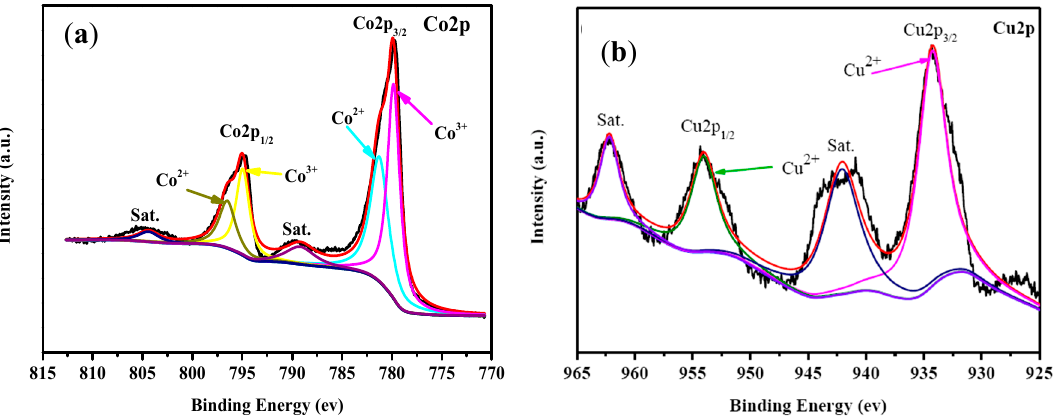
Figure 5. XPS spectra of the CuCo 2 O 4 nanoplatelets in Co2p ( a ) and Cu2p ( b ) regions.